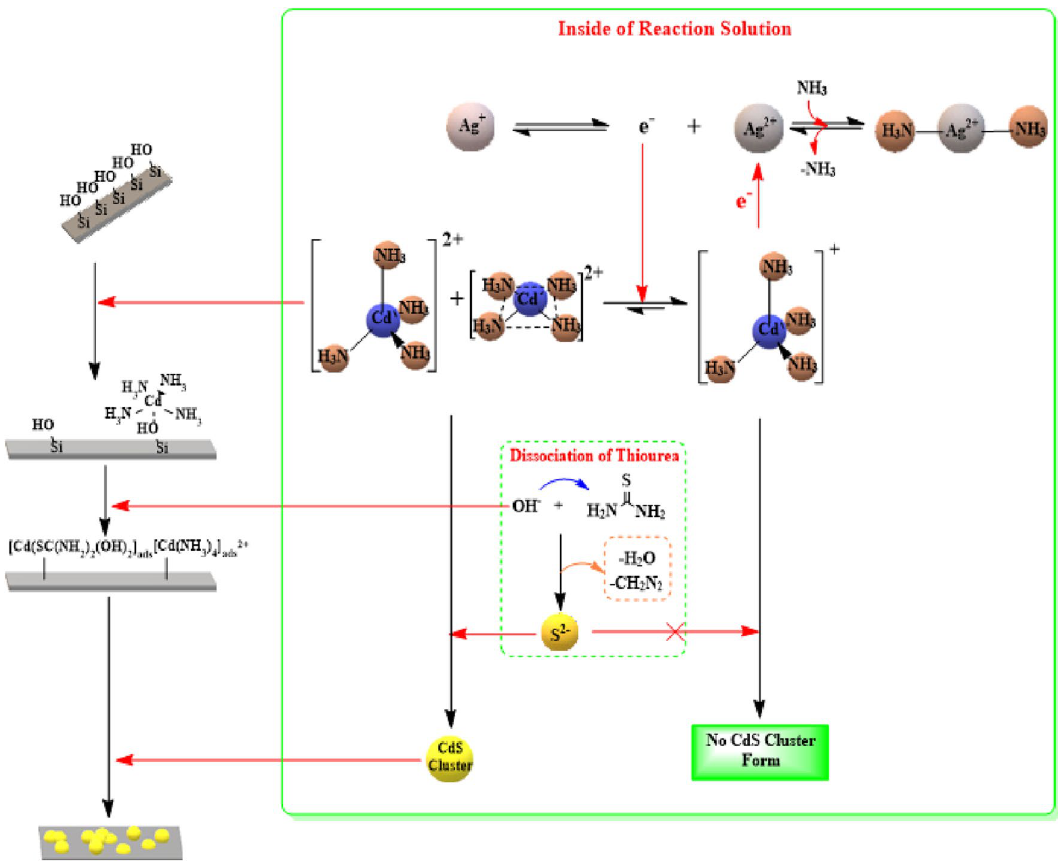
Figure 9. The growth mechanism of CdS + Ag in